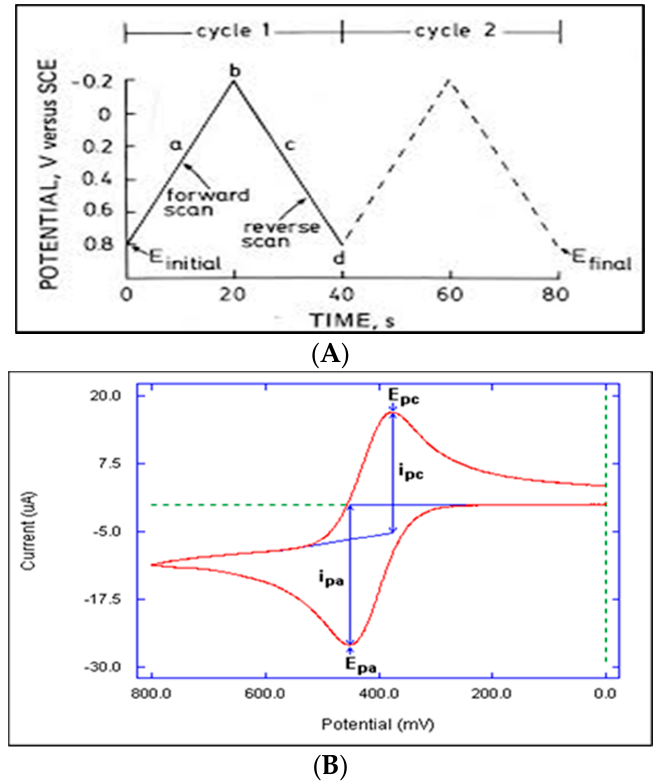
Figure 4. Cyclic voltammogram showing: ( A ) Potential against time (Reprinted with permission from [89]) ( B ) Current against potential. (Adapted from bioanalytical systems incorporated).